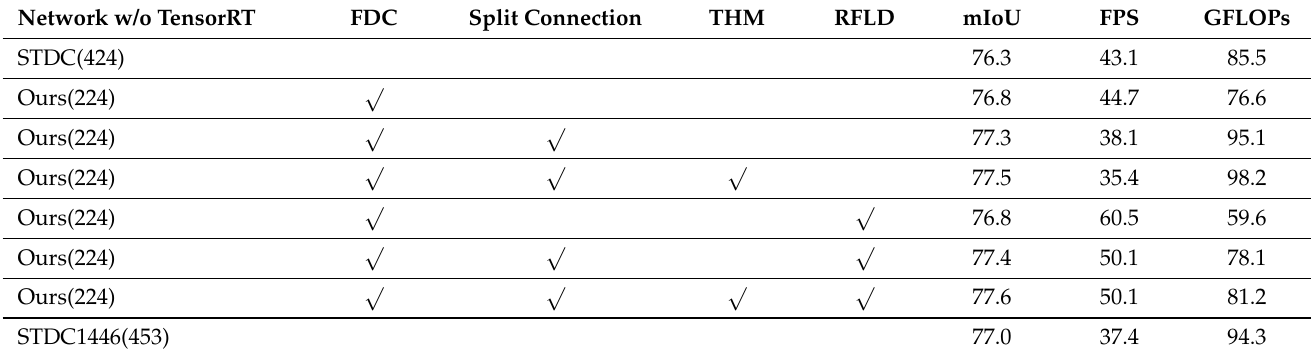
Table 3. Comparison of the accuracy and speed of the networks using different components on Cityscapes val set, the numbers behind the network denote the repetitions of STDC block, THM denotes three-level hierarchical module. RFLD denotes refined flexible and lightweight